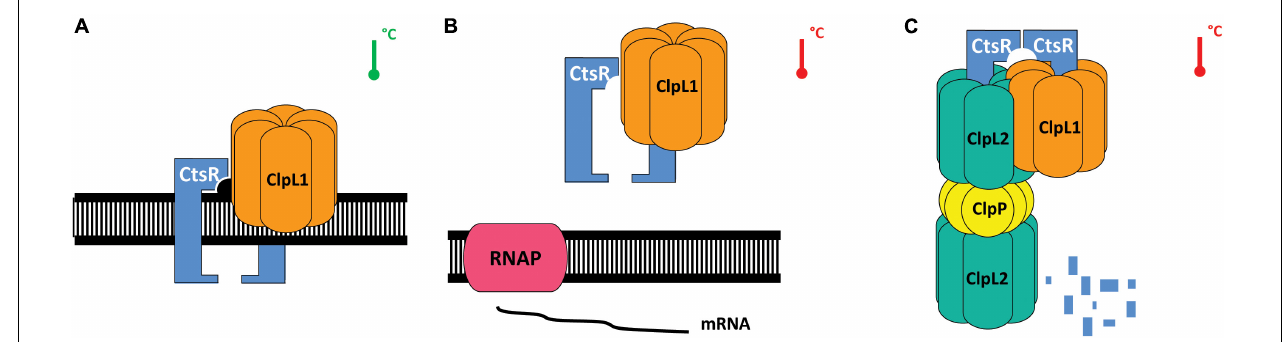
FIGURE 5 | Model for heat-dependent regulation of CtsR activity in O. oeni (adapted from Frees et al., 2007; Elsholz et al., 2010) During ideal conditions (depicted by the green thermometer), CtsR is most likely active as a dimer DNA-binding complex and binds to its operator sequences within the promoters of regulon members. ClpL1 binds CtsR to stabilize the regulator on its operator sequence (A) . Upon heat exposure (temperature threshold 33 ◦ C), represented by the red thermometer, CtsR undergoes a temperature-induced alteration of the winged HTH region that leads to dissociation of CtsR from the DNA (B) . Consequently, transcription of the repressed genes is induced. Free CtsR is presumably addressed by ClpL1 (C) to the ClpL2P proteolytic complex for degradation, preventing CtsR aggregation. CtsR is then re-activated to repress